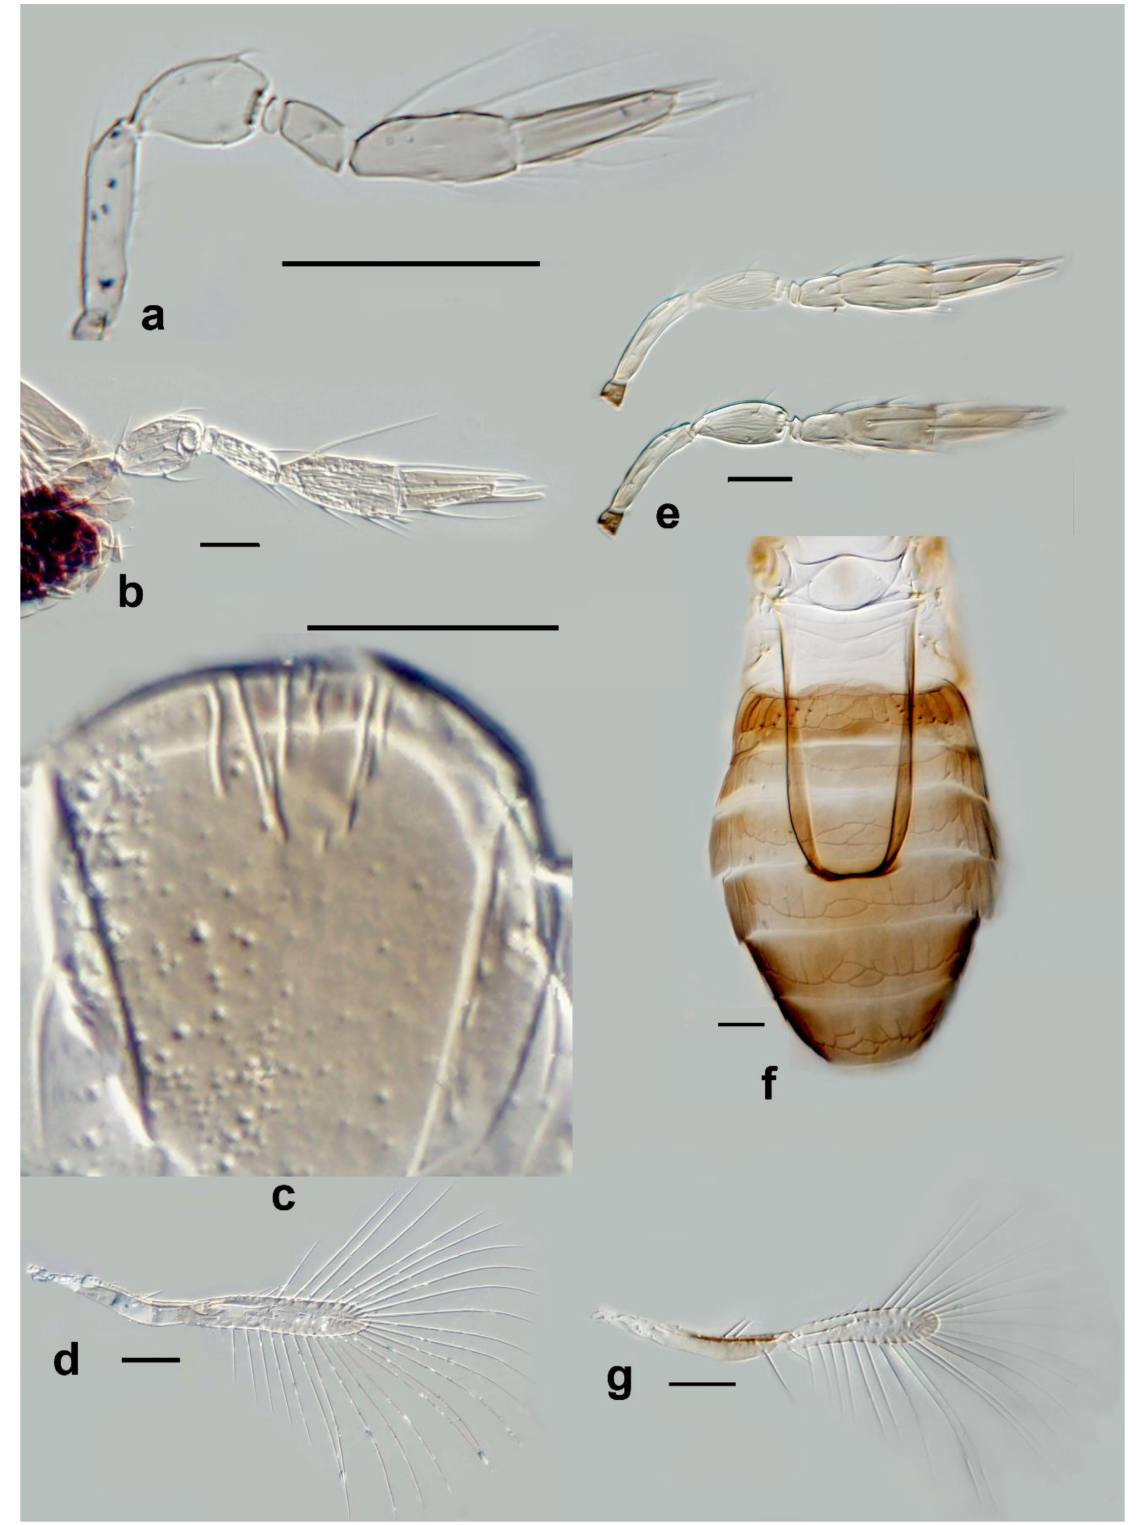
Figure 18. Photographs of Megaphragma species: ( a ) M. noyesi , female antenna (Holotype); ( b ) M. pintoi , female antenna (Holotype); ( c ) M. pintoi , female mesoscutum (Holotype); ( d ) M. pintoi , female fore wing (Holotype); ( e ) M. polilovi , female antenna (Holotype); ( f ) M. polilovi , female dorsal mesosoma (part) and metasoma (Holotype); ( g ) M. polilovi , female fore wing (Holotype). Scale bars 20 µ m except 50 µ m for a, d, and